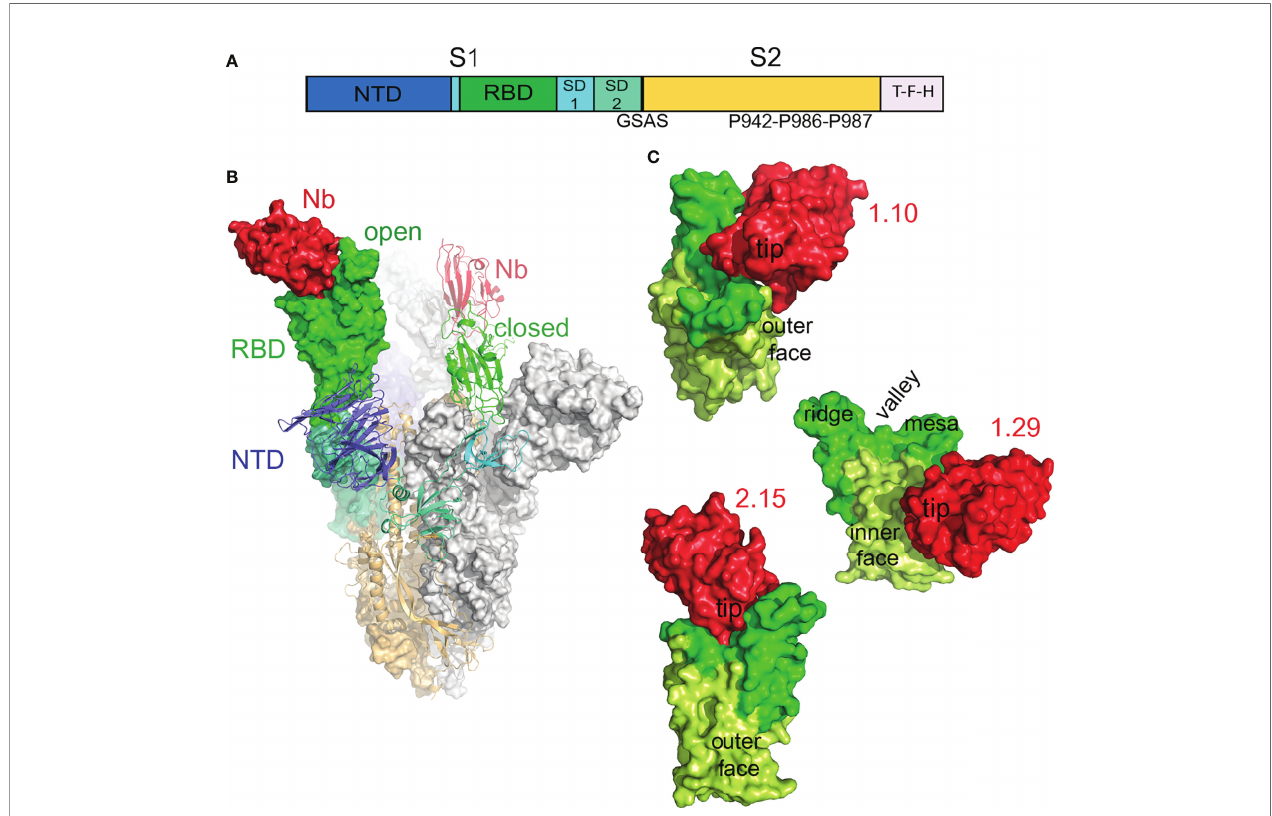
FIGURE 5 | Cryo-EM structure of the SARS-CoV-2 S in complex with RBD-speci fi c Nbs. (A) Scheme of the S construct used to generate the S-Nb complexes. The extracelular S1 with the N-terminal domain (NTD), receptor-binding domain (RBD), subdomains 1 and 2, and the S2 region are shown colored. The soluble S contained a T4 trimerization domain (T), a Flag peptide (F), and a 6xHis-tag (H) at its C-termininal end. The furin site was substituted by the GSAS sequence and the indicated three prolines were introduced at the S2 region to enhance protein stability and expression. (B) Cryo-EM structure of the trimeric S in the prefusion form with a Nb (2.15) bound to its RBD. Models of the S and the Nb were fi tted into the cryo-EM map of the S-2.15 complex ( Figure S6 ), as described in Materials and methods. The S monomers with the open RBD are represented as surfaces, either with the domains colored as in A or in grey, whereas the monomer with the closed RBD is shown as ribbon with the domains colored. The two modeled Nbs bound to the RBDs are shown in red. (C) Structures of the SARS-CoV-2 neutralizing 1.10, 1.29 and 2.15 Nbs bound to the RBD. Surface representations of RBD-Nb modeled in the cryo-EM maps shown in Figure S6 ; the RBDs are shown with the RBM in green, the RBD core in light-green and the Nbs in red. The RBD surfaces facing toward (inner) or opposity (outer) to the S trimer center, and the RBM regions are